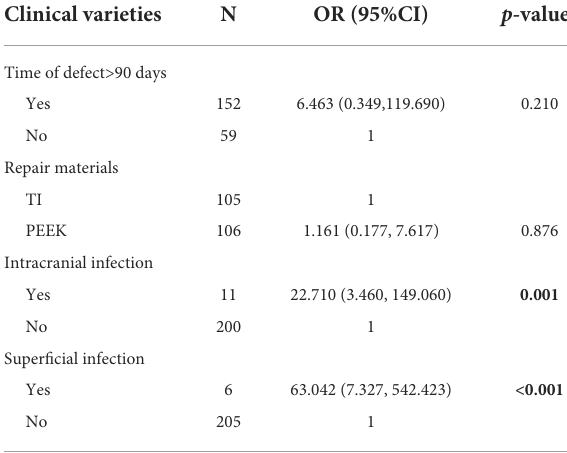
TABLE 7 Multivariate logistics regression analysis on pneumocephalus.